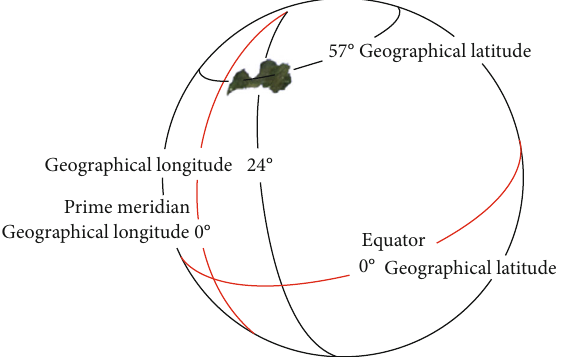
Figure 4: Geographic latitude and longitude in Latvia [4].